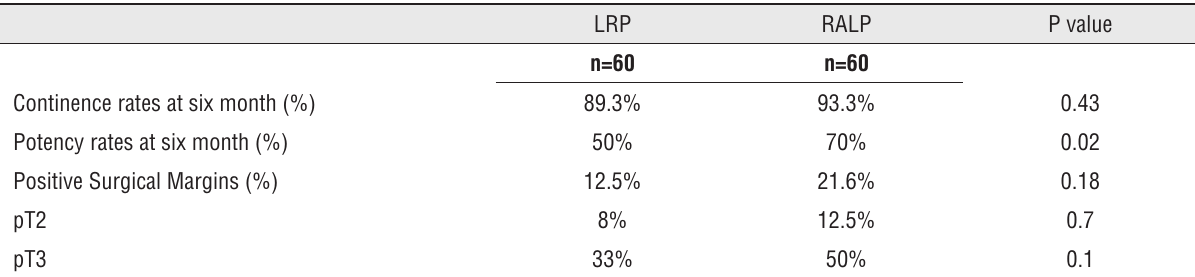
Table 3 - Functional and oncological outcomes. Robotic-assisted radical prostatectomy presented higher percentage of potency continence at six months and positive surgical